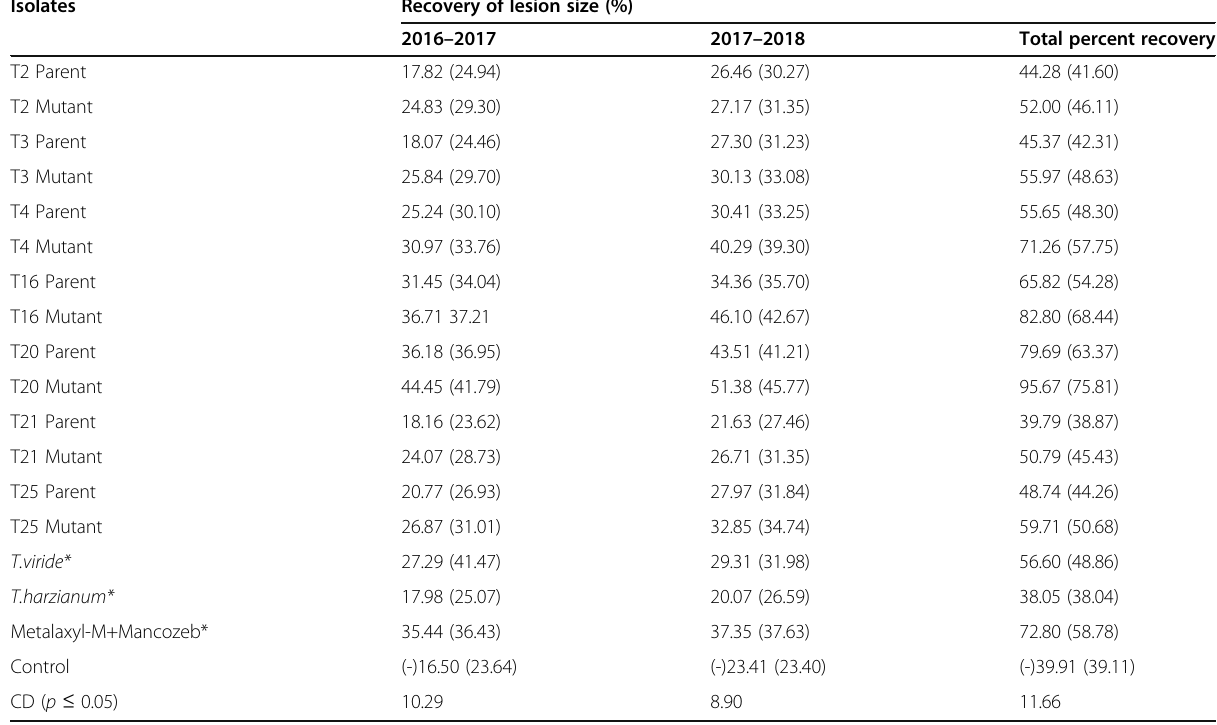
Table 4 Relative efficacy of Trichoderma parent and mutant isolates on percent recovery of lesion size